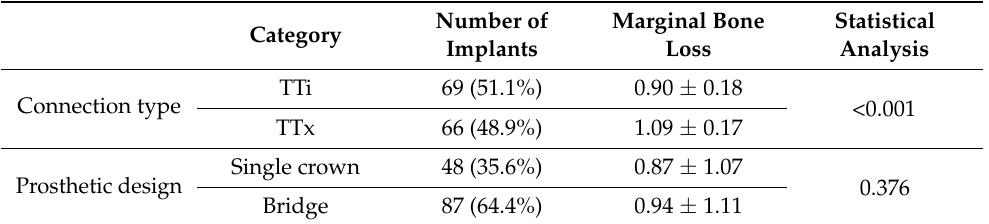
Table 4. Category, number of implants, marginal bone loss, and statistical analysis according to connection type and prosthetic design.